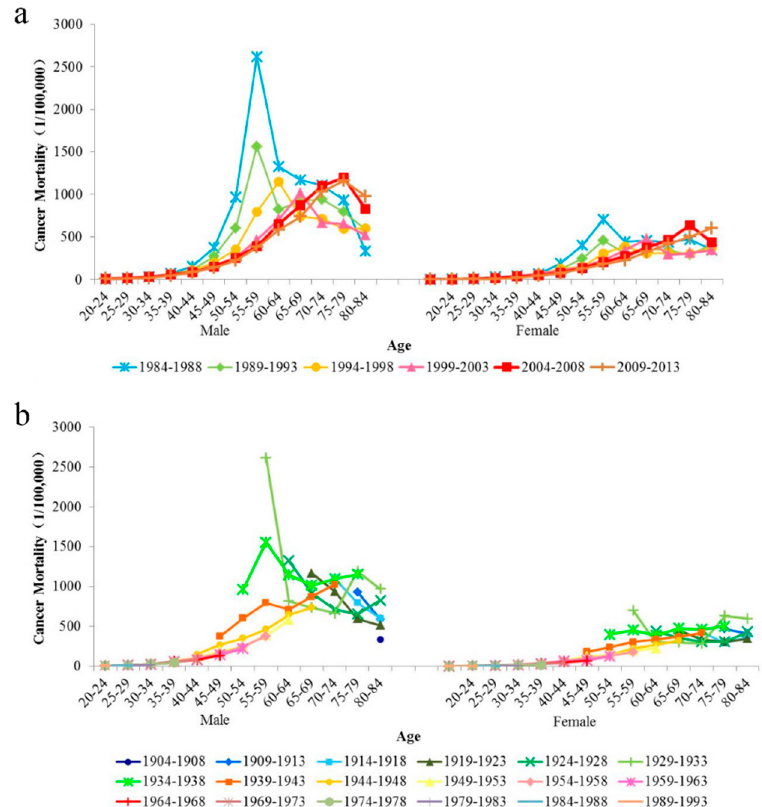
Figure 2. Age-specific cancer mortality rates of Macheng City residents, male and female, 1984–2013. ( a ) The age-specific cancer mortality by period. ( b ) The age-specific cancer mortality by birth cohort.